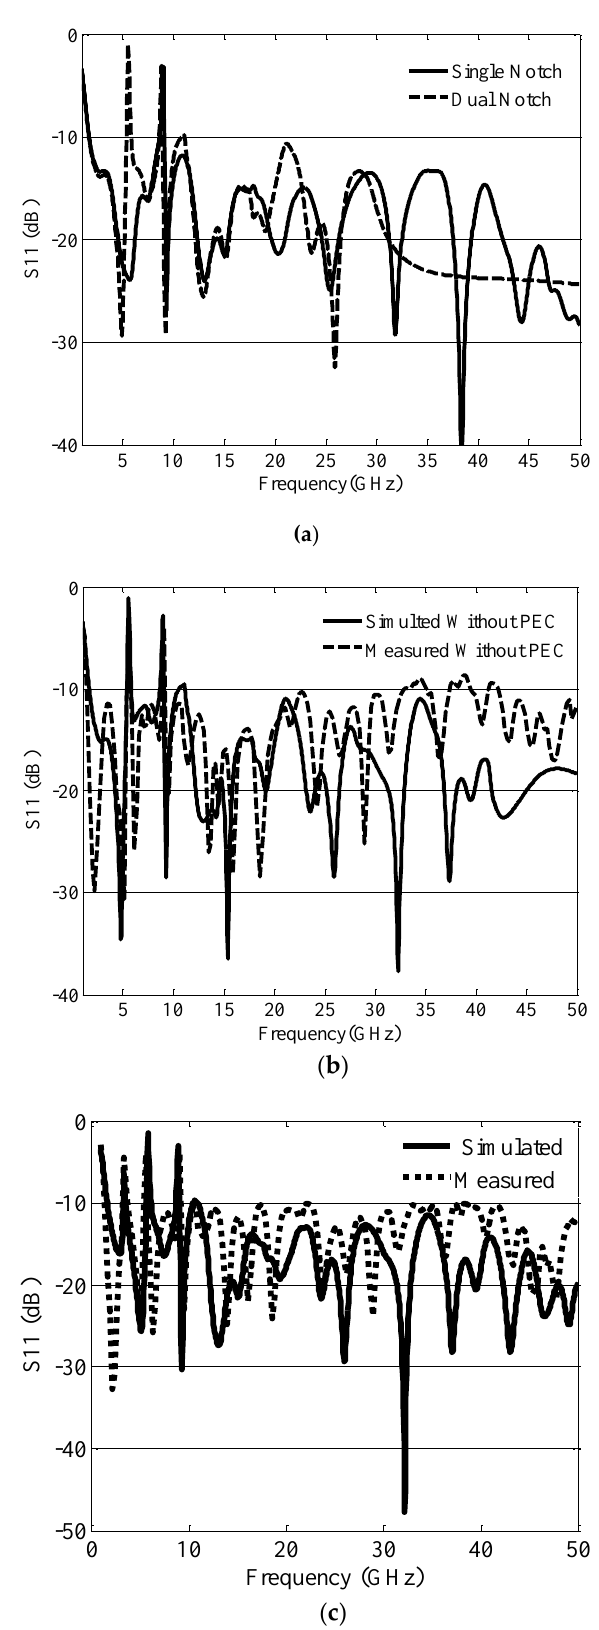
Figure 8. The simulated return loss for: ( a ) Loading single and dual rectangular split ring resonators (RSRRs); ( b ) simulated and measured return loss for the case I of Figure 3; ( c ) simulated and measured return loss for case II of Figure 3.